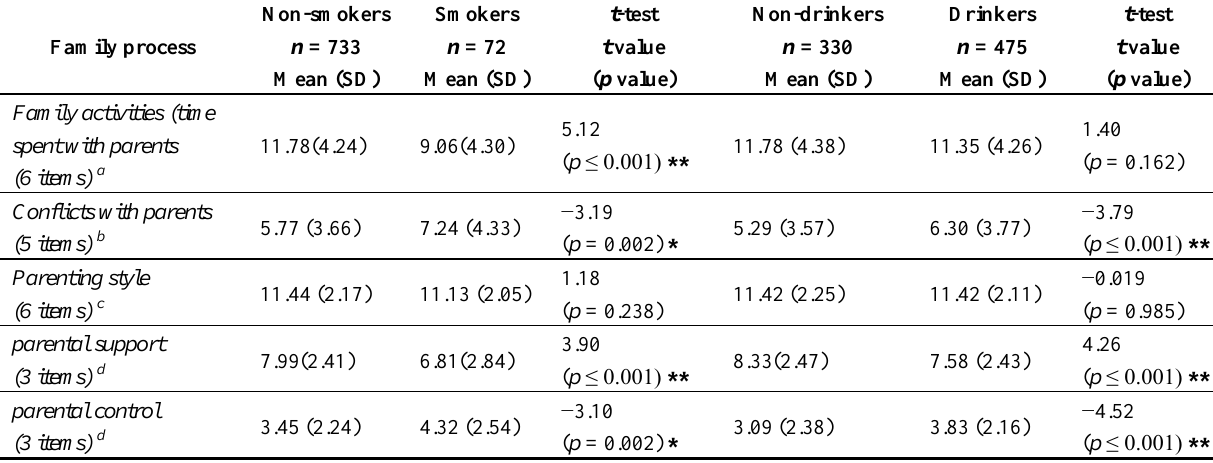
Table 3. Comparison of family process between adolescents with and without health risk behaviors ( n =